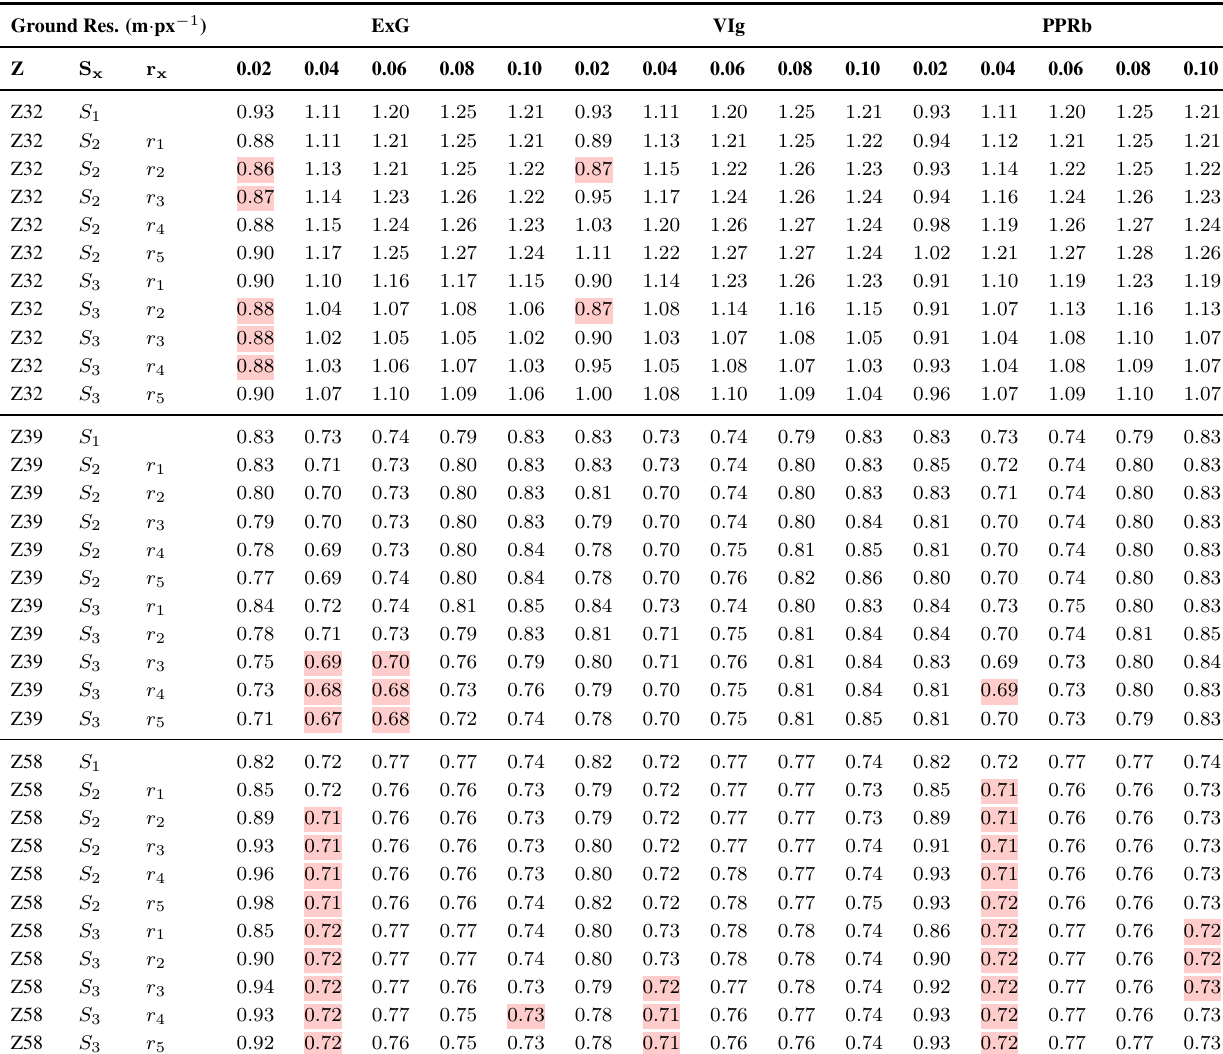
Table 6. The resulting root mean squared errors of prediction (RMSEP) of the leave-one-out cross-validation for evaluation of the predictive quality of applying strategies S combinations of VIs, aerial image ground resolutions, crop growth stages and computed Ridler